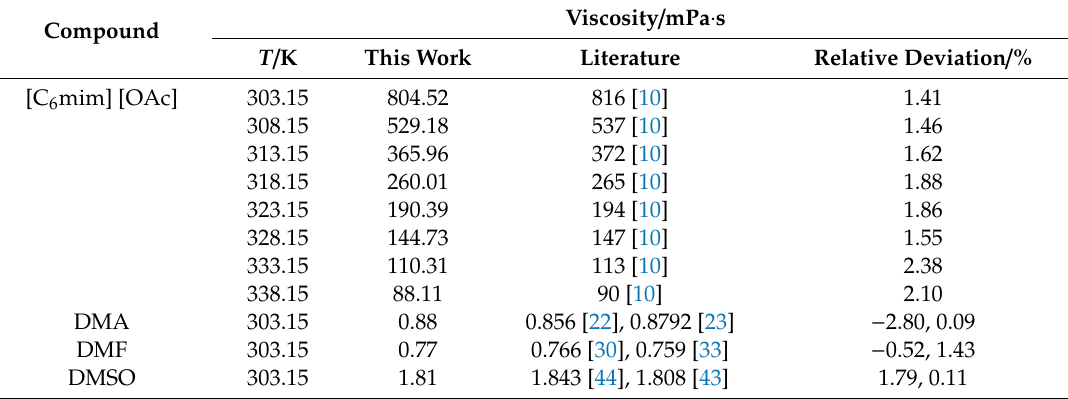
Table 9. Viscosities of pure compounds at (0.0967 ± 0.002